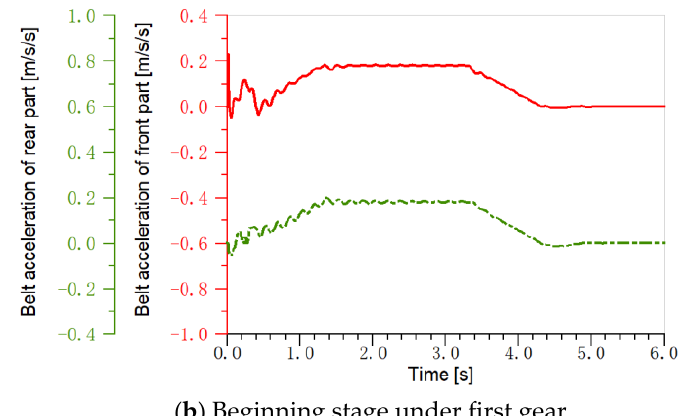
Figure 10. Belt acceleration curve.